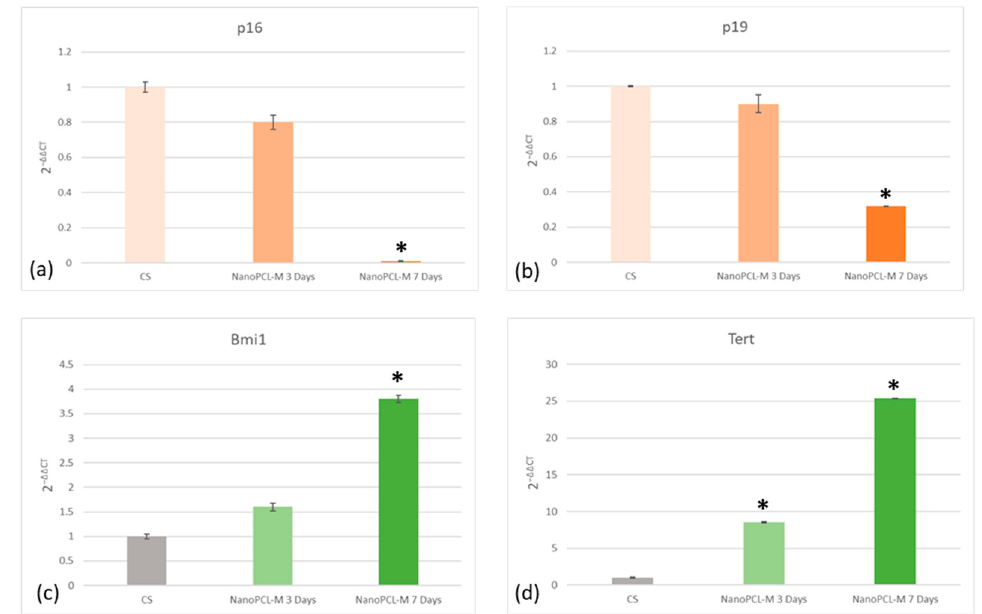
Figure 6. Effect of NanoPCL-M pretreatment on the expression of p16 ( a ), p19 ( b ), Bmi1 ( c ) and TERT ( d ). Skin stem cells exposed (T) or not (CS) to three to seven days of NanoPCL-M pretreatment were stressed by UV light. The amount of mRNA from NanoPCL-M treated cells was normalized to HPRT1 and was plotted as fold change (2 − ∆∆ CT ) relative to the mRNA expression of UV stress control (CS). * p value ≤ 0.05.